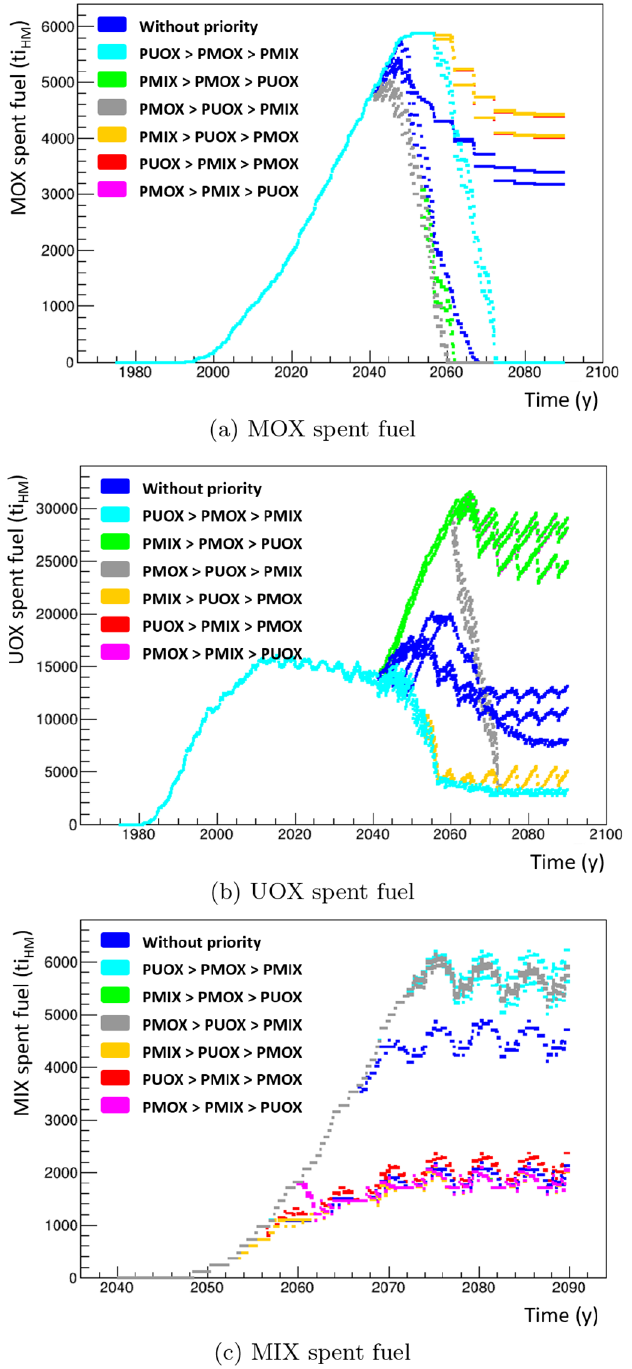
Fig. 9. Evolution of spent fuel stockpiles according to repro- cessing strategies.